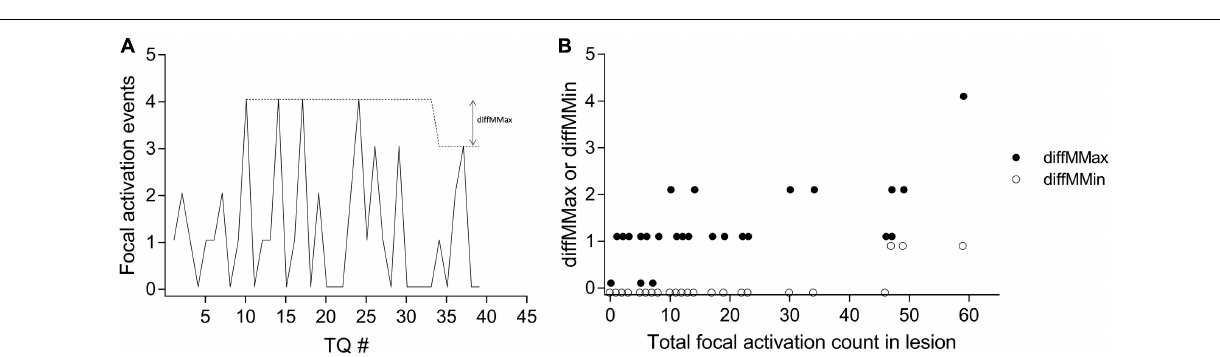
FIGURE 7 | Demonstrating the temporal consistency of focal activation events. (A) In one patient, for each consecutive TQ interval, the number of observed focal activation events for one ablated region is shown by the solid line. The dotted line indicates the MMax (moving maximum) for the region, and an example of the derivation of diffMMax is shown. (B) The variation in the consistency of focal activation as measured by diffMMax (filled circles) and diffMMin (unfilled circles) across all 51 lesions from all 10 patients are shown. See main text for